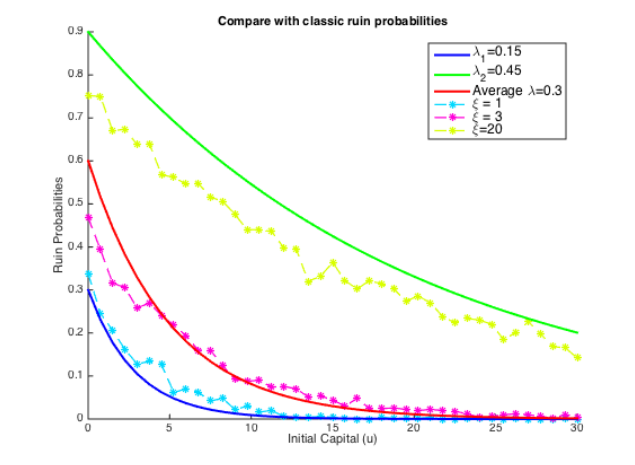
Figure 5. Comparison with classic ruin probabilities with exponential